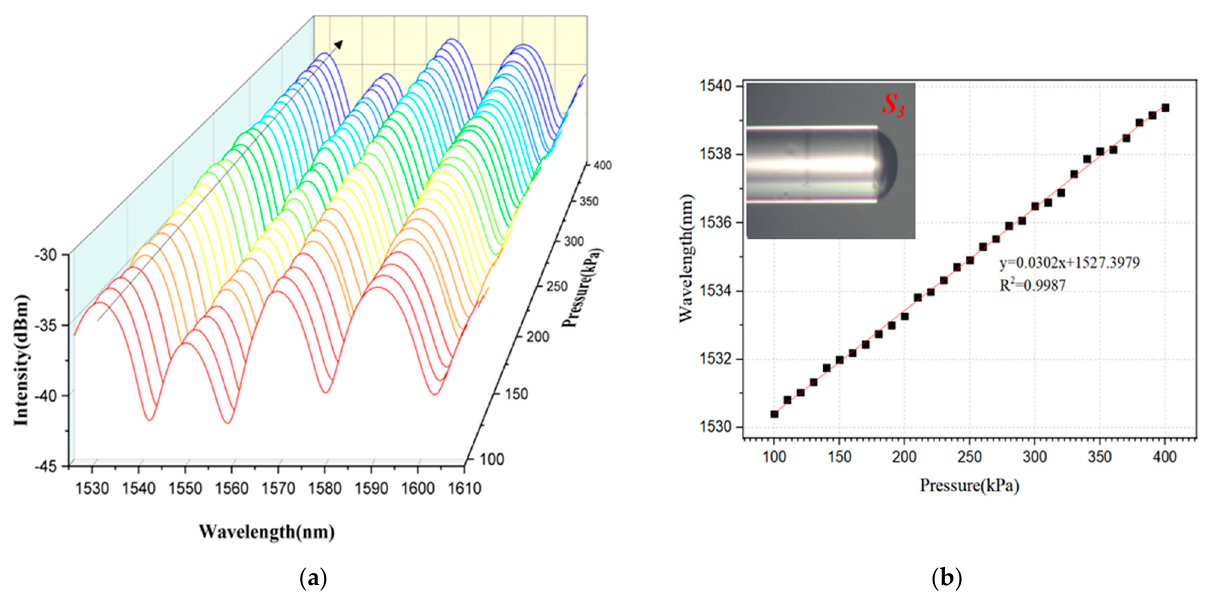
Figure 12. ( a ) The gas pressure (ranging from 100 to 400 kPa, in strides of 10 kPa) response interference spectrum of S 3 (PDMS/Ecoflex0030); and ( b ) pressure sensitivity of S 3 . Table 3. Comparison for the performances of the proposed sensor and existing reports. Sensor